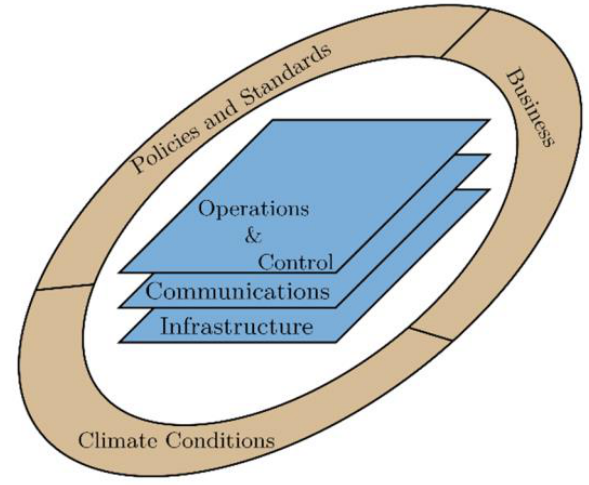
Figure 1. Microgrid (MG) layer structure (from Figure 2 in [7]) The six layers defined in this proposal are: